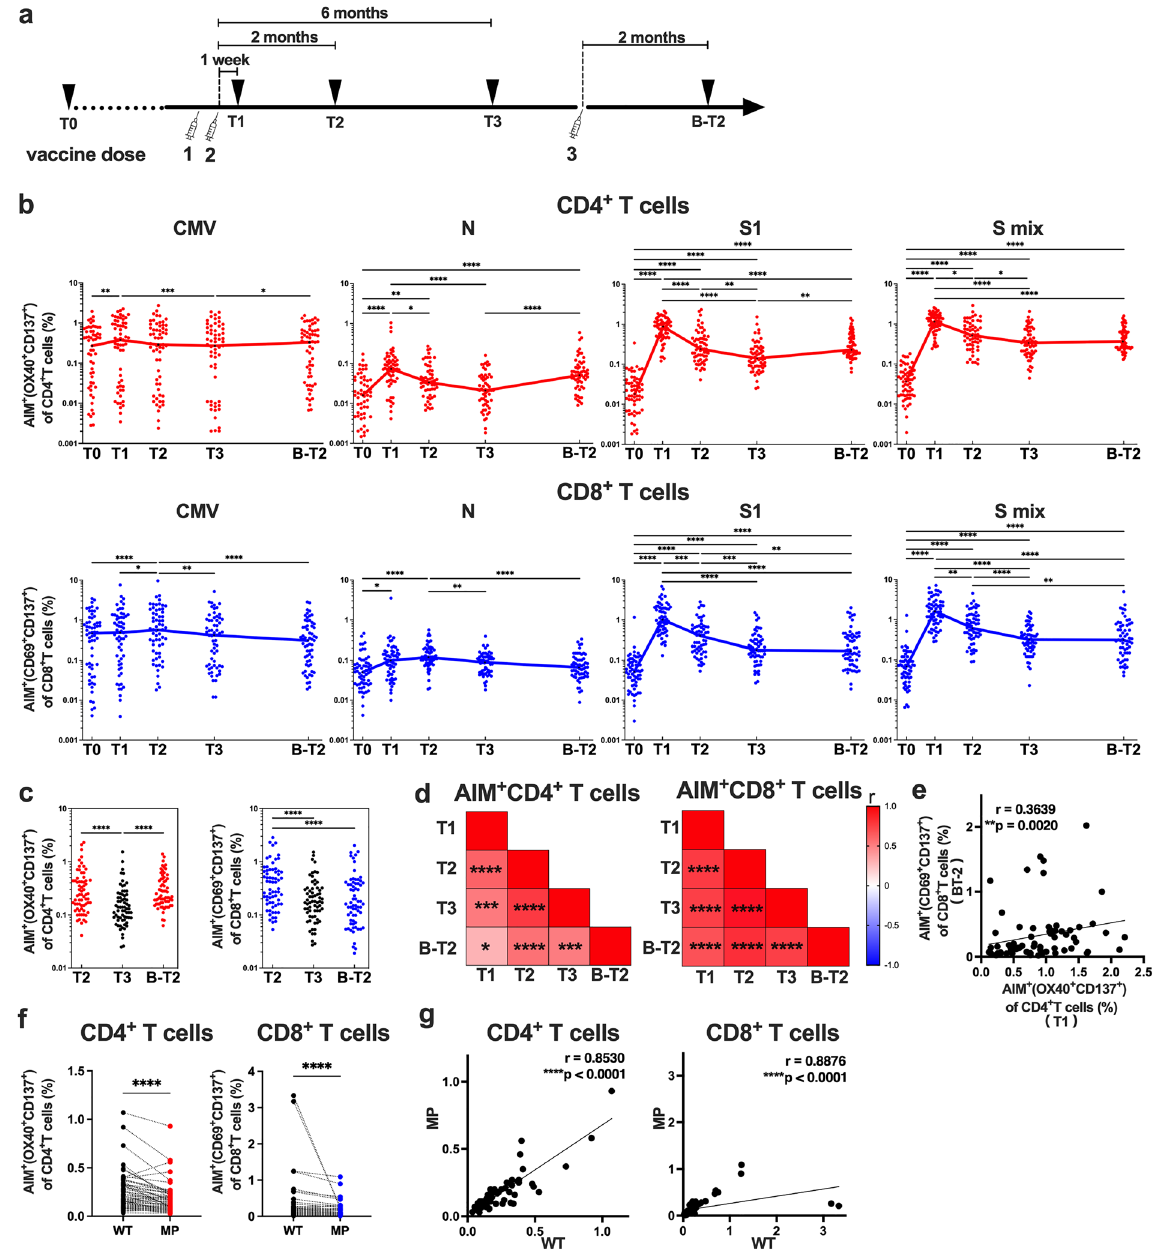
Figure 1. SARS-CoV-2 mRNA vaccine induced memory T cells against wild-type and Omicron spike proteins. Peripheral blood samples were obtained before (T0), 1 week (T1), 2 months (T2), and 6 months (T3) after the 2nd dose of the BNT162b2 mRNA vaccine and 2 months after the 3rd dose (B-T2). ( a ) The timeline of vaccinations and sample collections is shown. ( b – g ) Activation-induced marker (AIM) assays were performed using peripheral blood mononuclear cells (PBMCs) obtained at the indicated time points. PBMCs were stimulated with peptide pools of SARS-CoV-2 structural proteins, including the spike and nucleocapsid, cytomegalovirus pp65 protein as a control ( b – e ), and a mutant pool of the spike protein of the SARS-CoV-2 Omicron variant (MP) and wild-type reference pool (WT) ( f , g ). Twenty-two hours later, T cells responding to the indicated peptide pools were identified as AIM + (OX40 + CD137 + ) CD4 + T cells and AIM + (CD69 + CD137 + ) CD8 + T cells by flow cytometry. Frequencies of AIM + CD4 + T and AIM + CD8 + T cells at each time point ( b ) and at T2, T3, and B-T2 ( c ) are shown. ( d ) Heatmaps show the correlations among S1-reactive AIM + CD4 + T cell frequencies (left) and S1-reactive AIM + CD8 + T cell frequencies (right) at the indicated time points. ( e ) Correlation between the frequencies of S1-reactive AIM + CD4 + T cells at T1 and S1-reactive AIM + CD8 + T cells at B-T2. ( f ) Frequencies of AIM + CD4 + T and AIM + CD8 + T cells reactive to MP and WT pools at B-T2. ( g ) Correlations between MP- and WT-reactive AIM + CD4 + T cells and AIM + CD8 + T cells at B-T2. CMV, cytomegalovirus pp 65 protein; N, SARS-CoV-2 nucleocapsid; S1, SARS-CoV-2 spike S1 domain; S mix, a mixture of SARS-CoV-2 spike S1 and S2 domains. Each dot indicates the value for one individual. Significant differences were analyzed by the Friedman test ( b , c ) and Wilcoxon matched-pairs signed-rank test ( f ). Correlations were analyzed using Spearman’s correlation analysis ( e , g ). * P < 0.05, ** P < 0.01, *** P < 0.001, **** P <